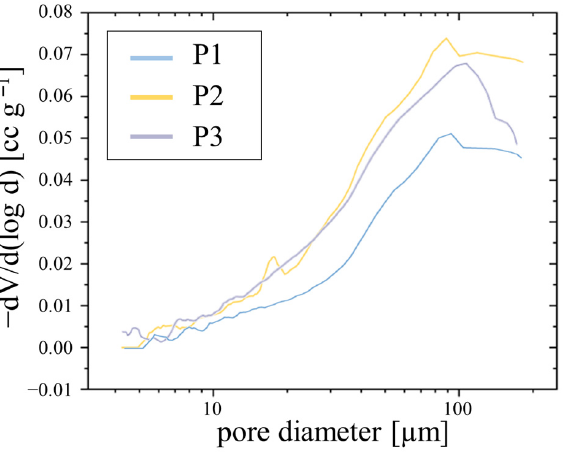
Figure 9. Pore size distribution of the vertically printed porous wick samples P1, P2, and P3.